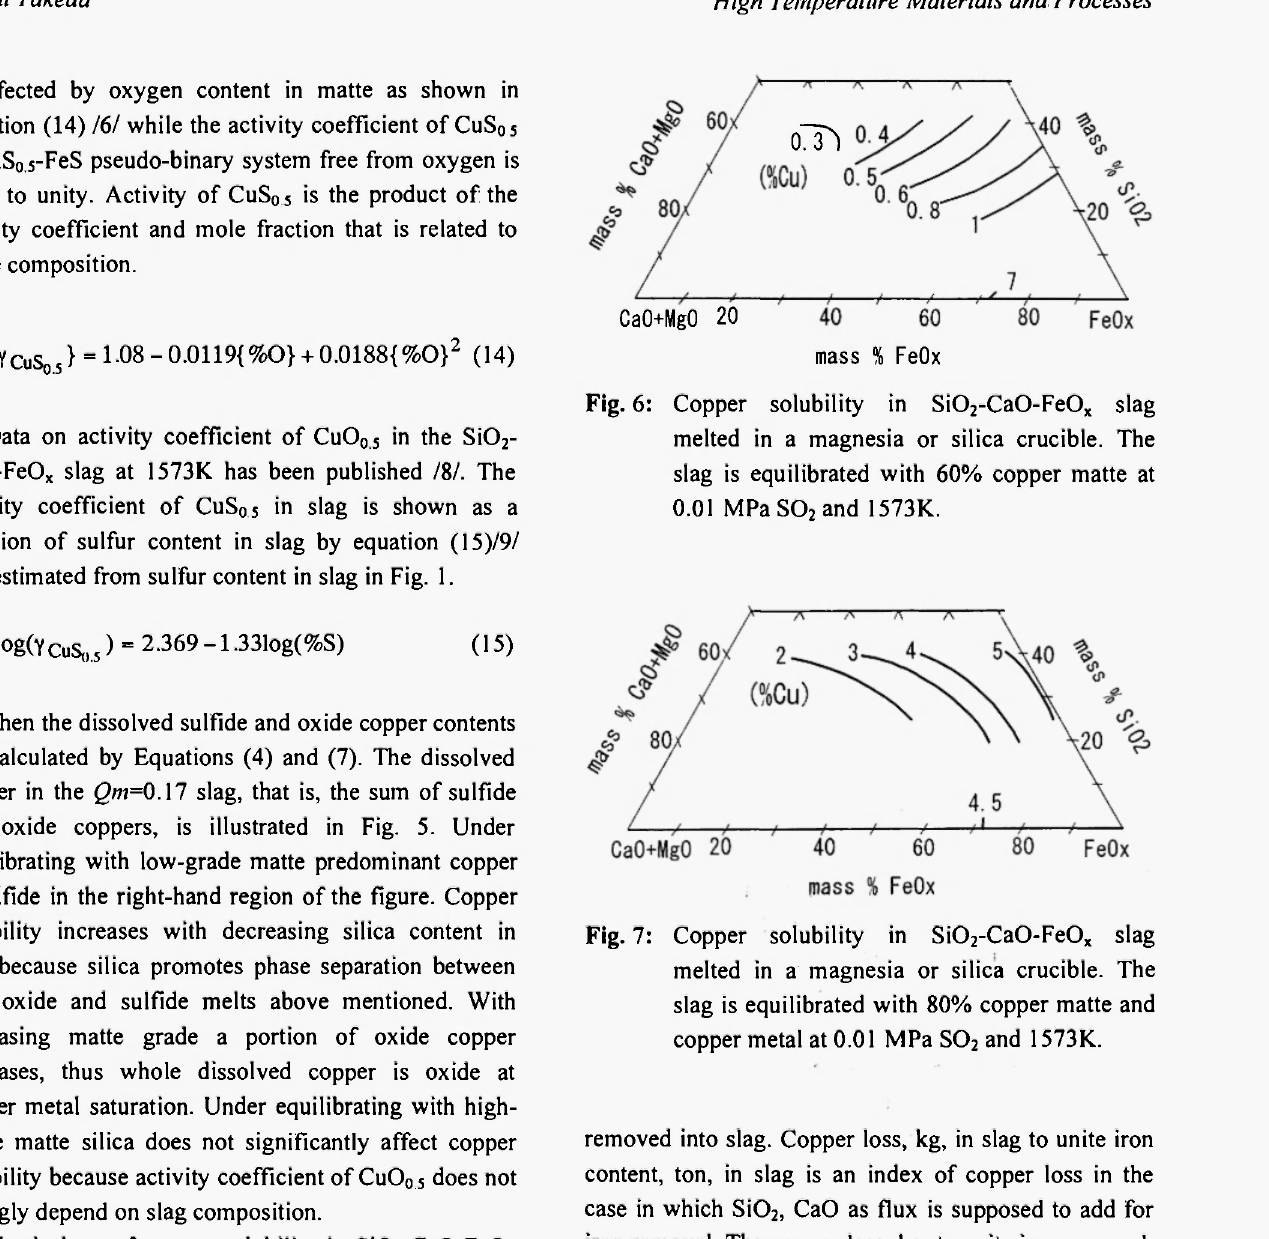
CaO+MgO mass % FeOx Fig. 6: Copper solubility in Si0 2 -Ca0-Fe0 x slag melted in a magnesia or silica crucible. The slag is equilibrated with 60% copper matte at 0.01 Μ Pa S0 2 and 1573K.